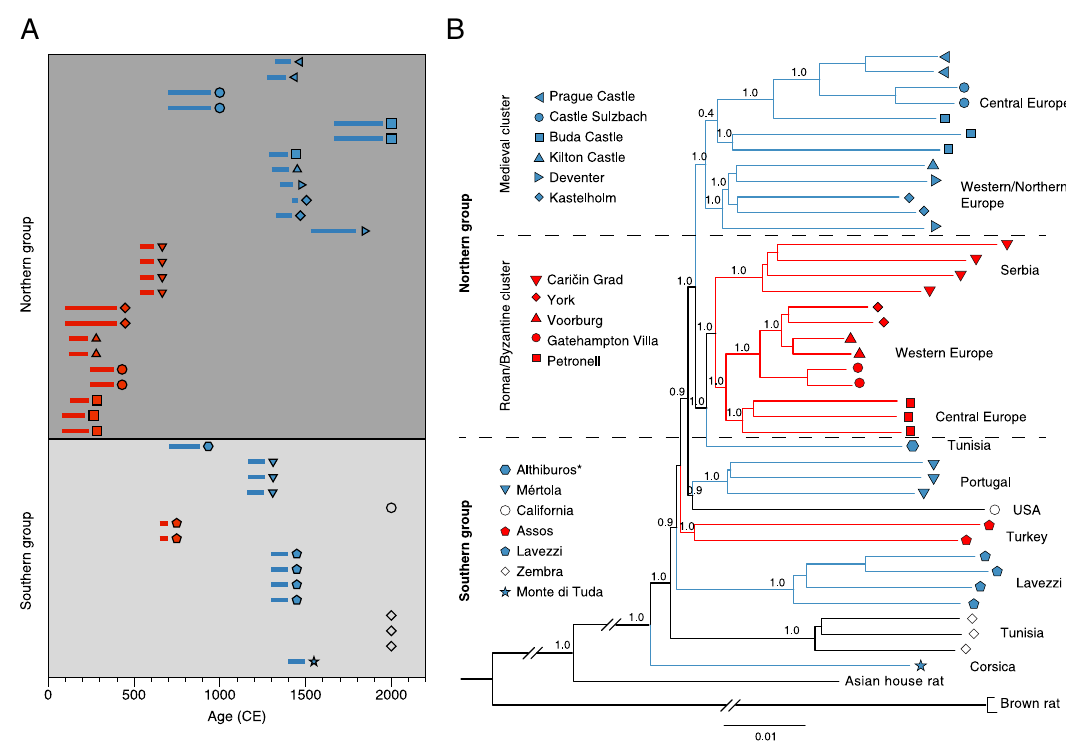
Fig. 3 Relationships of the ancient black rats over time and space. A The ages of the rat samples included in whole genome analyses. The bars represent 95.4% con fi dence intervals surrounding the direct radiocarbon dates or stratigraphic dates (Supplementary Data 3). The colours correspond to the Roman/Byzantine (red) and medieval (blue) time periods. The symbols represent the sampling sites listed in panel B, and the modern samples are represented by black symbols. B The phylogenetic relationship among ancient and modern black rats reconstructed using a neighbour joining phylogeny. The pairwise genetic distances were calculated using autosomal variants. The support values based upon 100 bootstrap replicates are shown on the nodes. The branches are coloured by sample ages as described in panel A , and the tip symbols correspond to the sampling site. * Though the medieval Tunisian (Althiburos) sample clusters geographically in the southern group, it falls in with the Roman cluster of the northern group in the